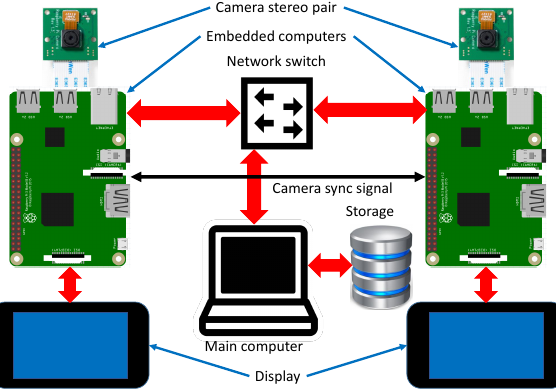
Figure 2. System hardware architecture